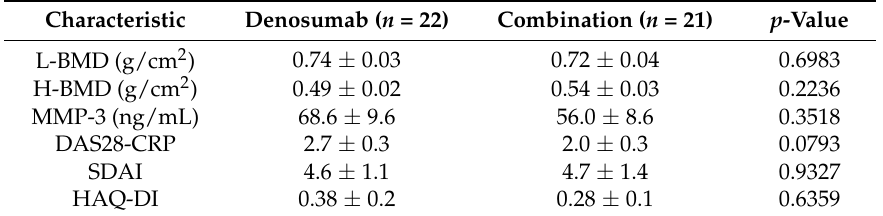
Table 2. Value changes at 12 months of treatment. D ata are expressed as mean ± standard error.